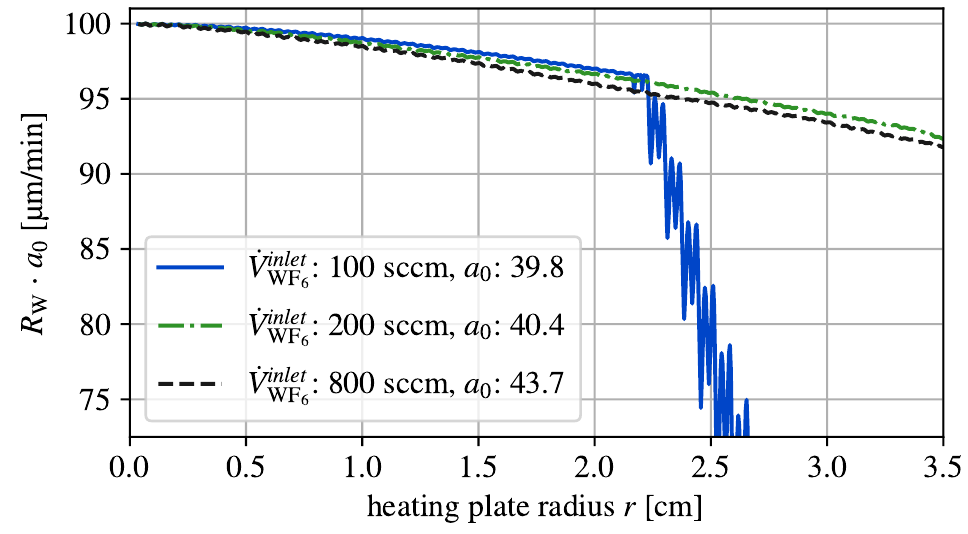
Figure 8. Variation of ˙ V inlet caption as in Figure